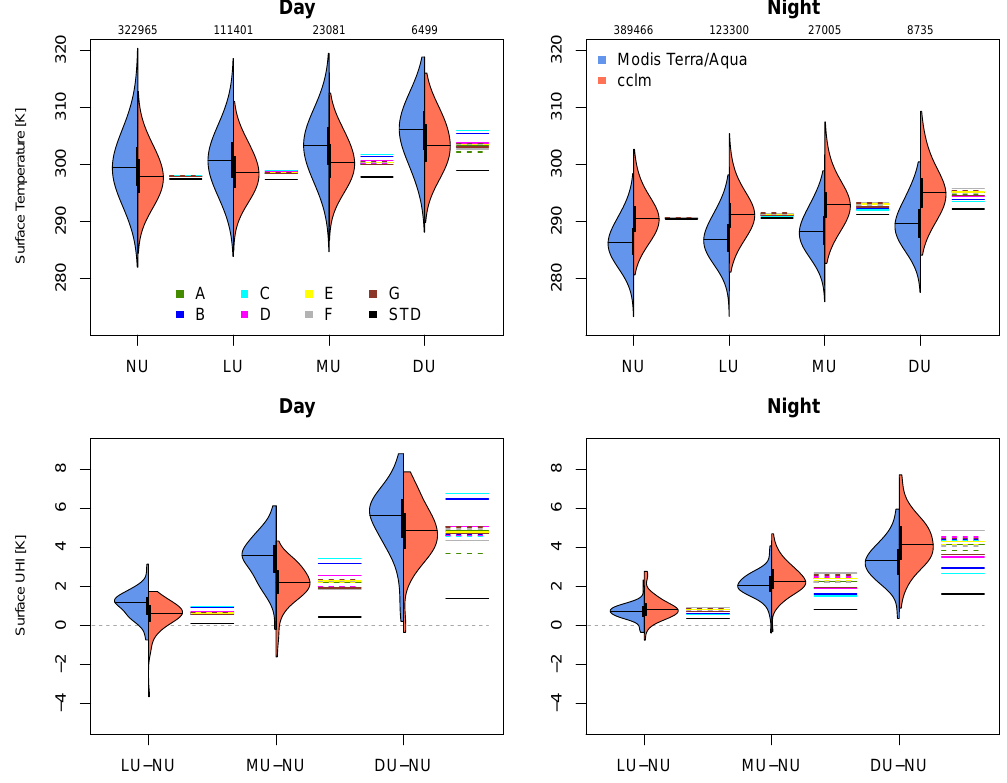
Figure 4. Evaluation of modelled land-surface temperatures against MODIS satellite observations. A distinction is made between four urban classes: no urban (NU) with impervious surface area (ISA) ≤ 0.05; light urban (LU) with 0.05 < ISA ≤ 0.25; medium urban (MU) with 0.25 < ISA ≤ 0.5; dense urban (DU) with ISA > 0.5. The amount of valid pixels are shown above each day and night plot. The violin plots represent the distribution of LST for MODIS in blue and the reference simulation (REF) with COSMO-CLM coupled to TERRA_URB v2.0 in orange. Full and dashed lines represent the median for the low (AL–GL) and high (AH–GH) scenarios from Table 2, respectively. The upper panels show the sample distributions of the absolute temperatures, whereas the lower panels show the sample distribution of the difference between median of each urban class (LU, MU and DU) with the NU